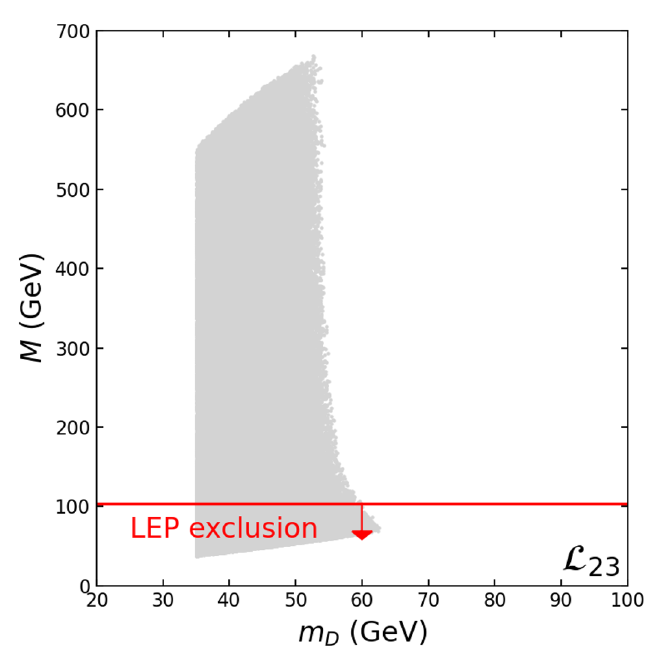
Figure 5 . Samples with ∆ χ 2 in 2 σ region for L 23 . The horizontal red solid lines are the LEP upper limit 103.5 GeV [33]. Only the gray region where the conservative systematic uncertainties are taken into account can escape from the LEP